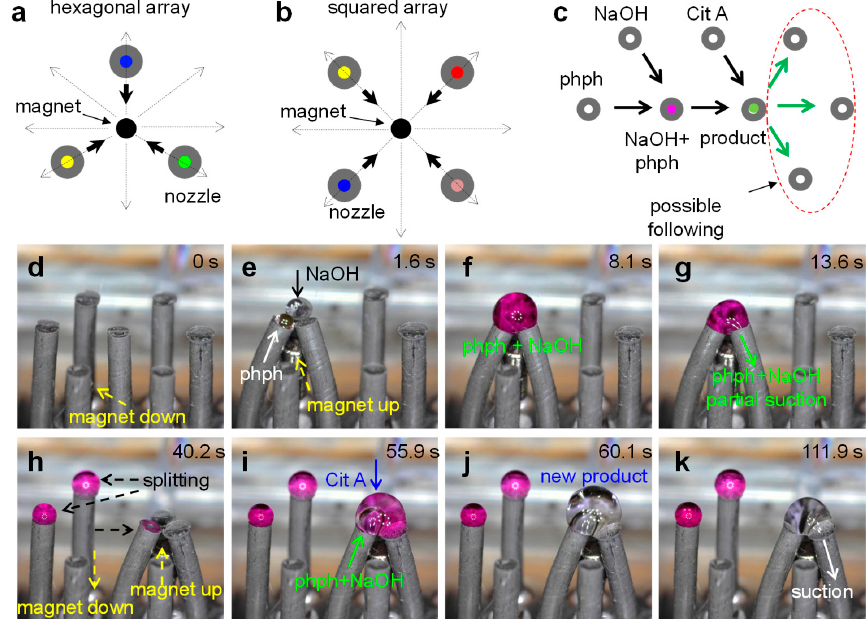
Figure 5. Versatility for combinatorial paths. Array of magnetic nozzles with a ( a ) hexagonal layout and a ( b ) square layout interacting with a magnetic field (top view). ( c ) Example of a two-step reaction path diagrammatically sketched. ( d – k ) Step-by-step of two-step reaction.